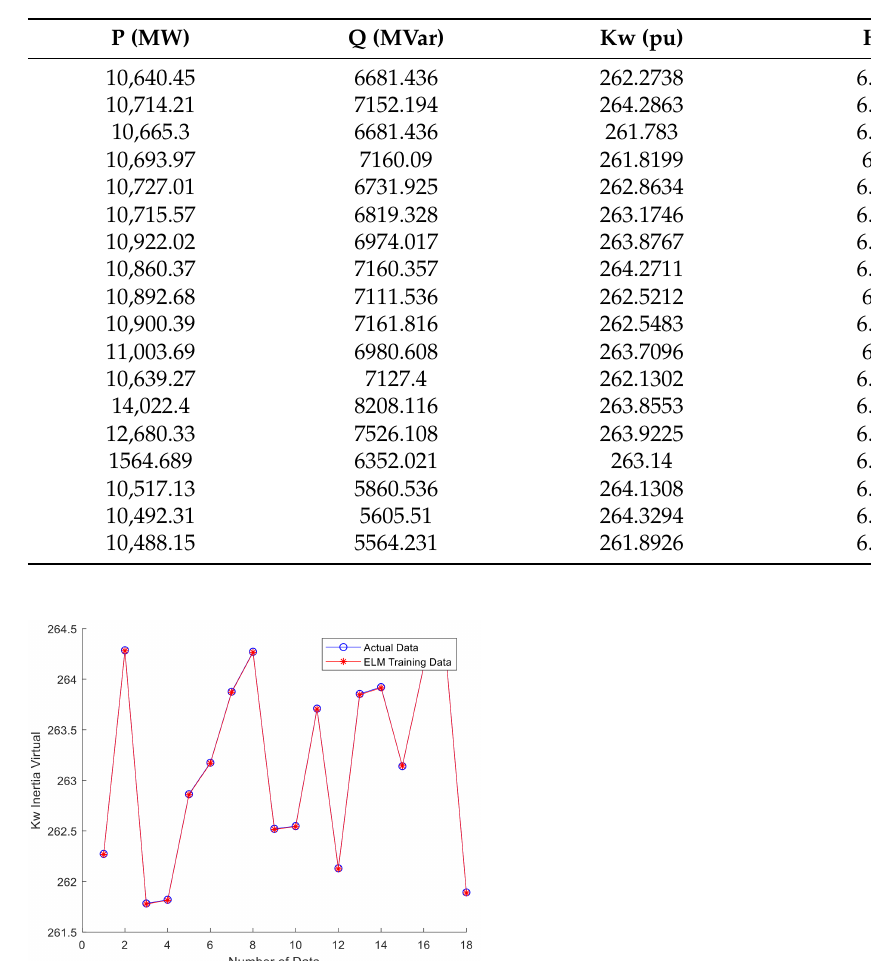
Table 2. Operating conditions and VISMA parameters.